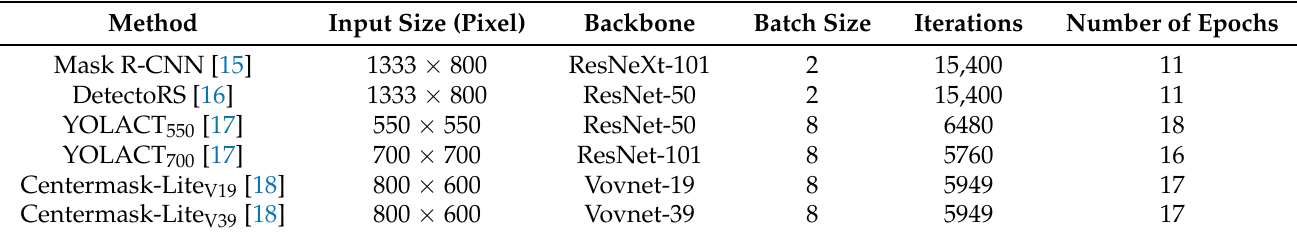
Table 2. Configurations during training for each method evaluated.